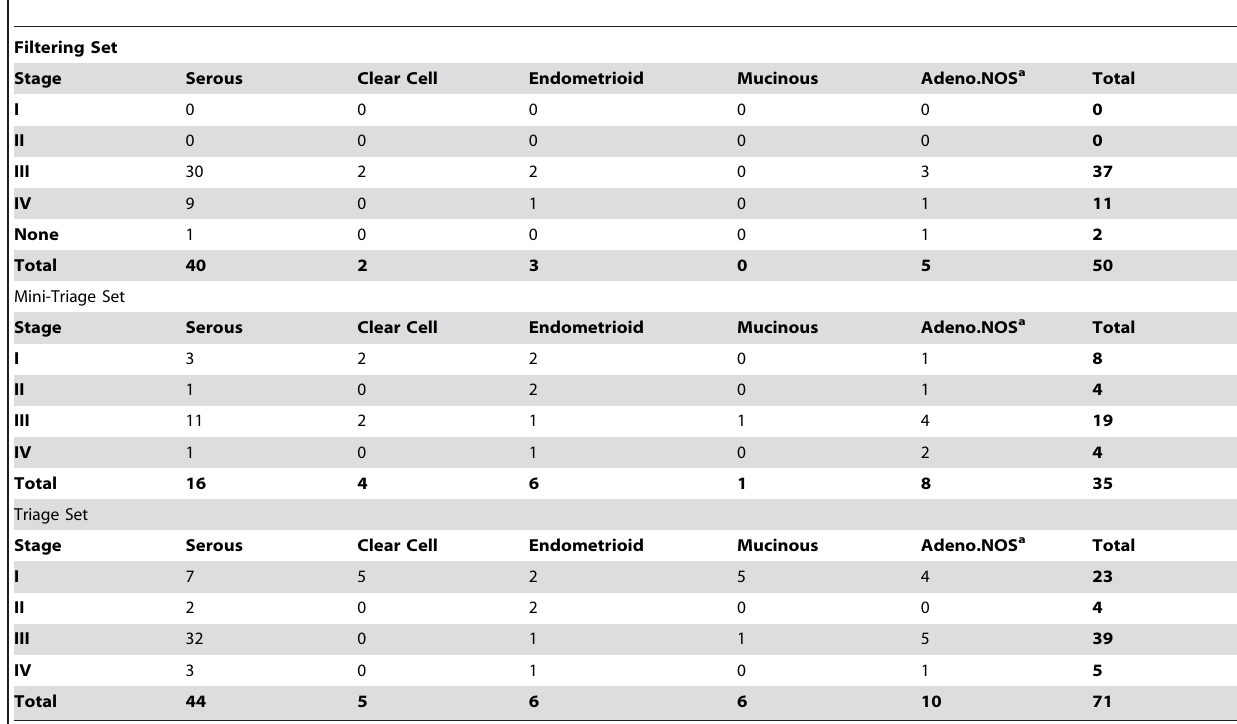
Table 2. Stage and histology of ovarian cases in each serum set.